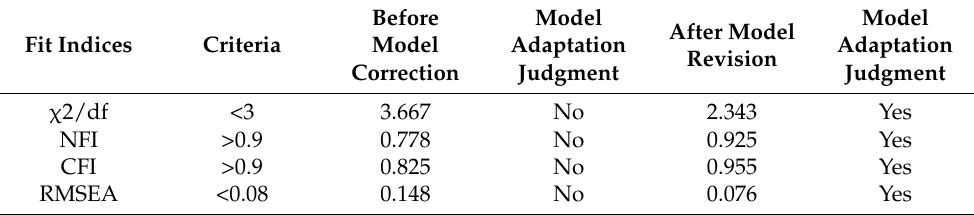
Table 7. Measurement of model fit indices.